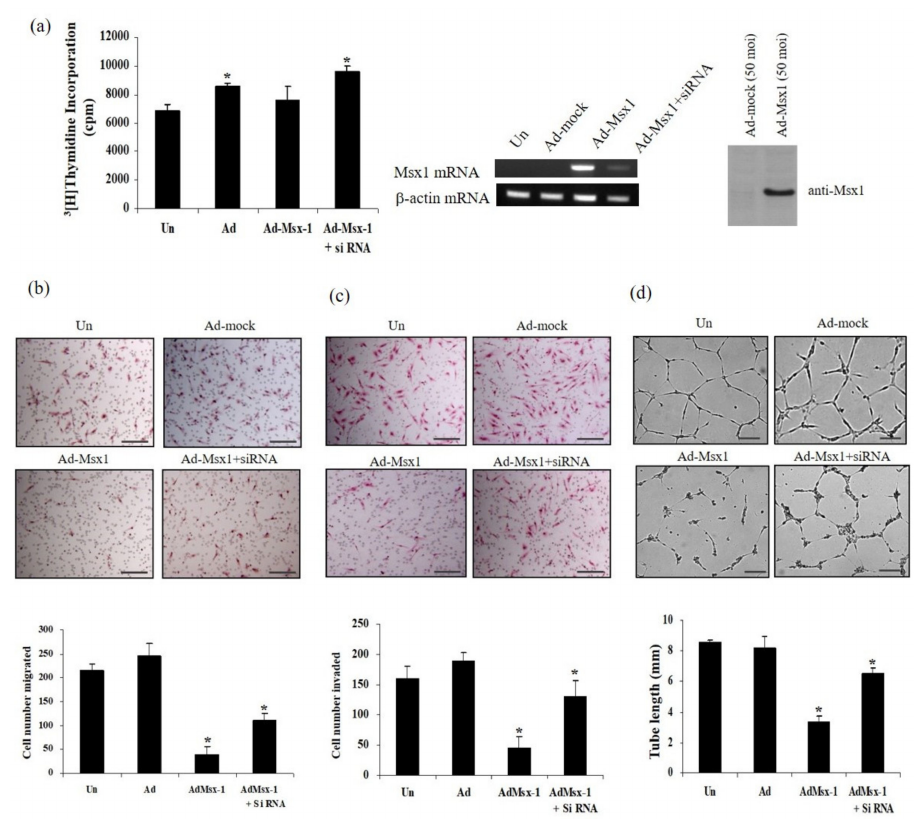
Figure 1. Msx1 inhibits endothelial cell migration, invasion, and tube formation in vitro. ( a ) siRNA-mediated suppression of Msx1 in HUVECs. HUVECs were either uninfected (Un) or infected with Ad-Mock, Ad-Msx1, or Ad-Msx1 with siRNA for Msx1 (Ad-Msx1 + siRNA) for 18 h and then treated with the vascular endothelial growth factor (VEGF) (10 ng / mL) for 24 h. Expression of Msx1 was confirmed by RT-PCR and immunoblotted with anti-Msx1 antibody. Incorporated [ 3 H]-thymidine was determined by liquid scintillation counting. ( b and c ) Uninfected HUVECs and indicated adenovirus-infected HUVECs were seeded onto Transwells for migration assay ( b ) or on Matrigel-coated Transwells for invasion assay ( c ), followed by stimulation with VEGF (25 ng / mL) for 24 ( b ) or 30 h ( c ), respectively. The number of migrated or invaded cells was counted under a light microscope, and mean values were determined. Independent experiments were repeated three times, and error bars correspond to 95% confidence intervals. * p < 0.05 compared to uninfected controls. ( d ) Uninfected HUVECs and adenovirus-infected HUVECs were plated on growth factor-reduced Matrigel and then treated with or without VEGF (10 ng / mL) for 48 h. Formation of tubular structures was detected by an inverted microscope. Tube lengths were quantified, and error bars correspond to 95% confidence intervals. The scale bar represents 100 µ m * p < 0.05 indicates a significant di ff